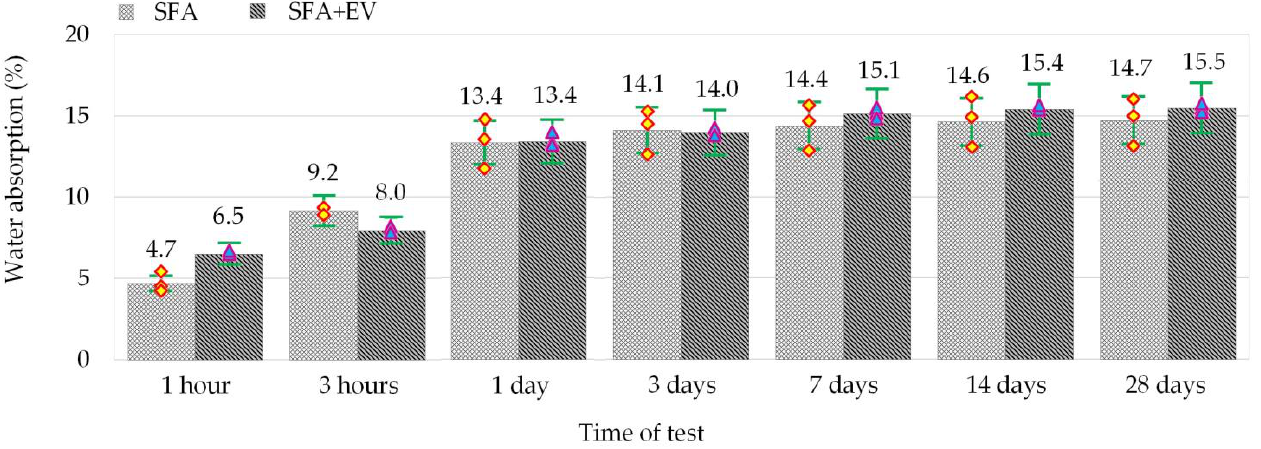
Figure 6. Water absorption of SFA and SFA + EV concretes